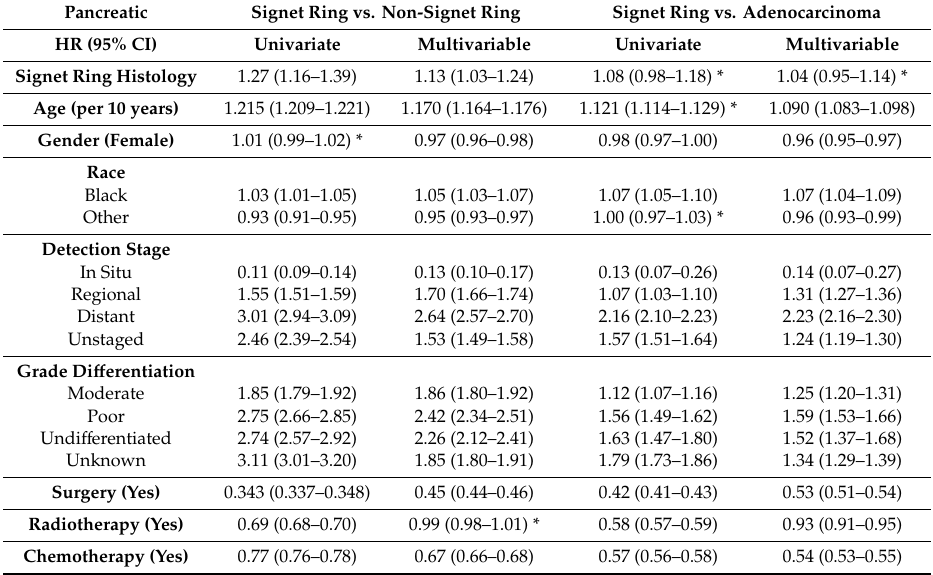
Table 12. Derived univariate and multivariable Cox-proportional hazard ratios (HR) of mortality for pancreatic